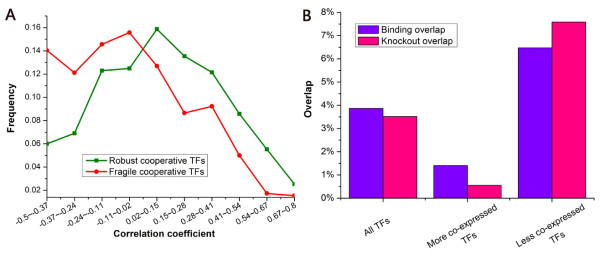
The difference between robust and fragile transcriptional regulatory programs in TF co-activity. (A) We calculated pair-wise Pearson correlation coefficient in expression profiles between robust cooperative TFs or fragile cooperative TFs. Distributions of resulting correlation coefficient values are presented for robust cooperative TFs (green) and fragile cooperative TFs (red). Higher positive correlation indicates high co-activity (co-expressed). Robust cooperative TFs show higher co-activity than fragile cooperative TFs. (B) The binding and knockout overlap for all TFs and two subsets of TFs (see Materials and Methods). TFs that are more co-expressed (co-activity) with all other TFs have lower overlap, while TFs that are less co-expressed with all other TFs have greater overlap. Low overlap indicates robust transcriptional regulatory program.